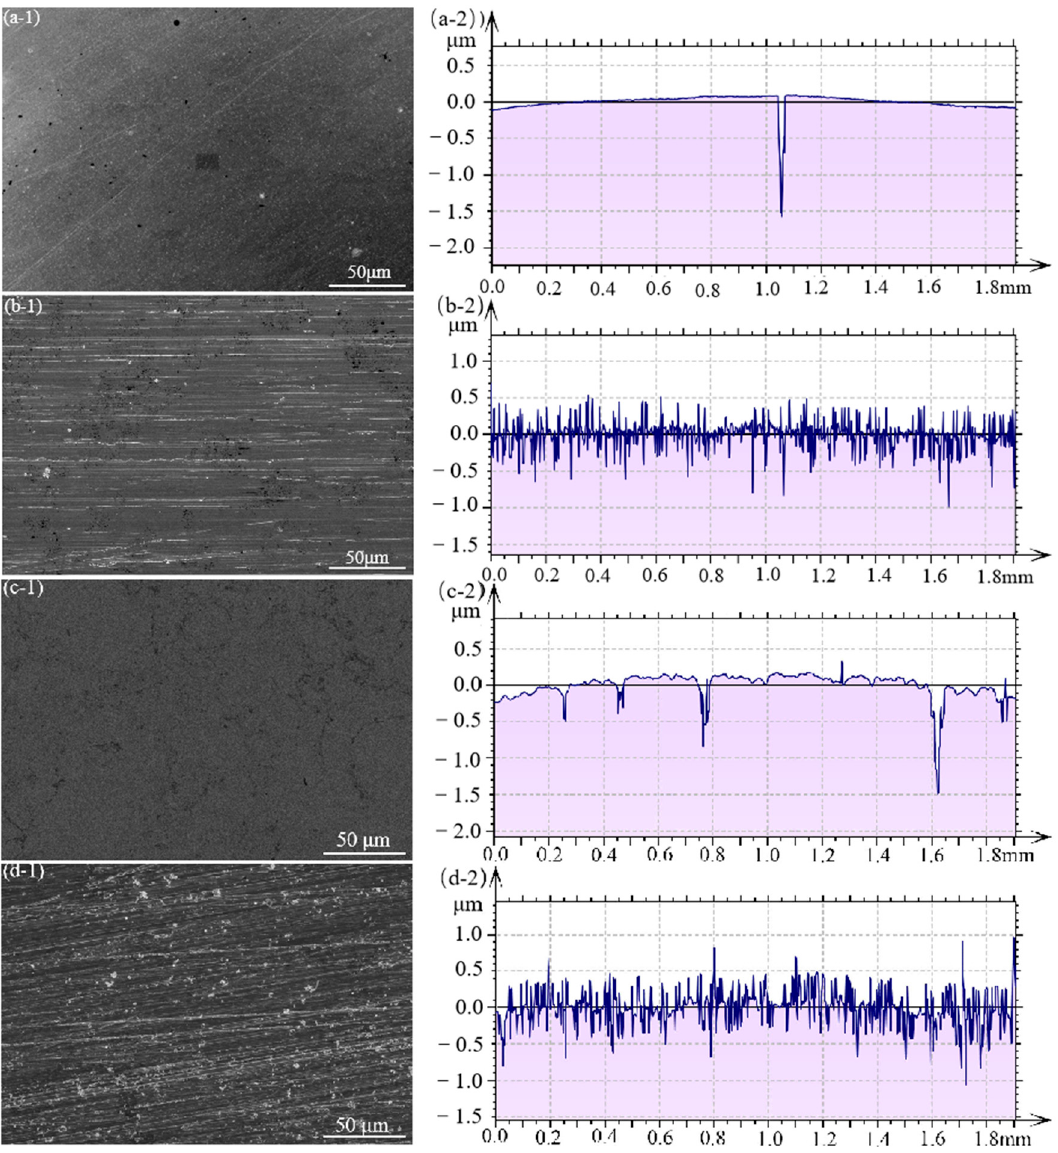
Figure 2. Surface ( -1 ) and linear profiles ( -2 ) of the 316L ( a ), ground 316L ( b ), coating ( c ), and ground coating ( d ) samples.